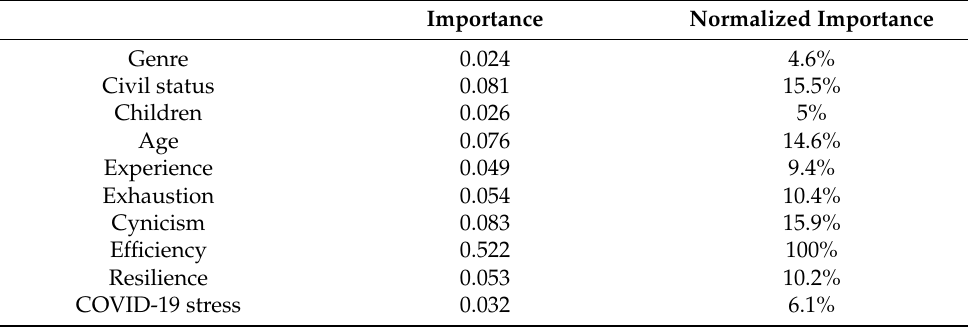
Table 3. Importance of independent variables in the artificial neural